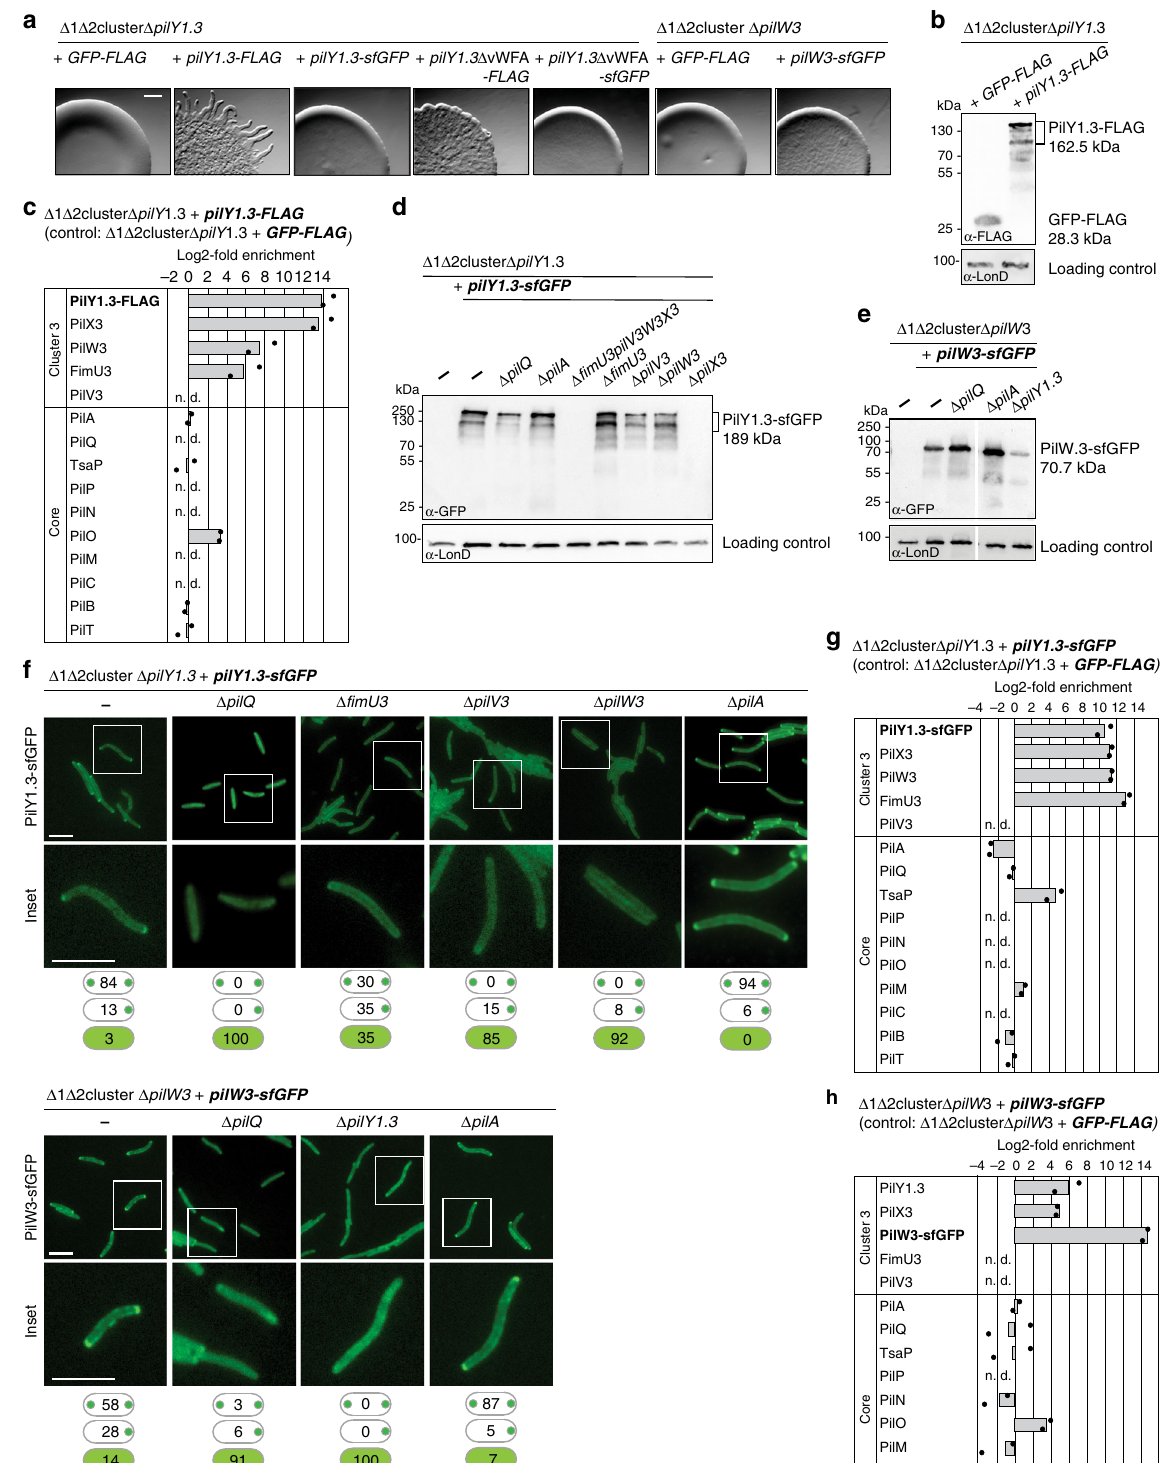
theoretical size of ~7 nm in diameter if calculated as a single (Fig. 3c, g, h) and the minor pilins interact with PilA (Fig. 2a, b). globular protein), thus making this arrangement unlikely. Next, We fi rst hypothesized that the minor pilins would make up the we considered that PilY1.3 also interacts with PilO in the lower part of the short stem above PilA, and PilY1 would make up periplasmic ring in the pull-down experiments. Because sequence the plug. However, the size of the plug density (~4 nm in analysis suggests that PilY1.3 contains two globular domains, i.e., diameter; Fig. 4b, fi rst column) is not suf fi ciently large to fi t the the N-terminal vWFA domain and the C-terminal PilY1 domain, entire PilY1.3 protein (molecular weight of ~160 kDa giving a NATURE COMMUNICATIONS| (2020) 11:5054